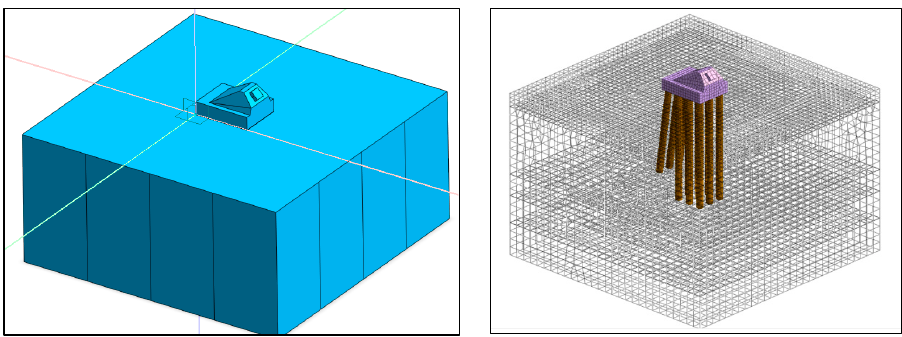
Figure 8. Geometry model and 3D finite element mesh.